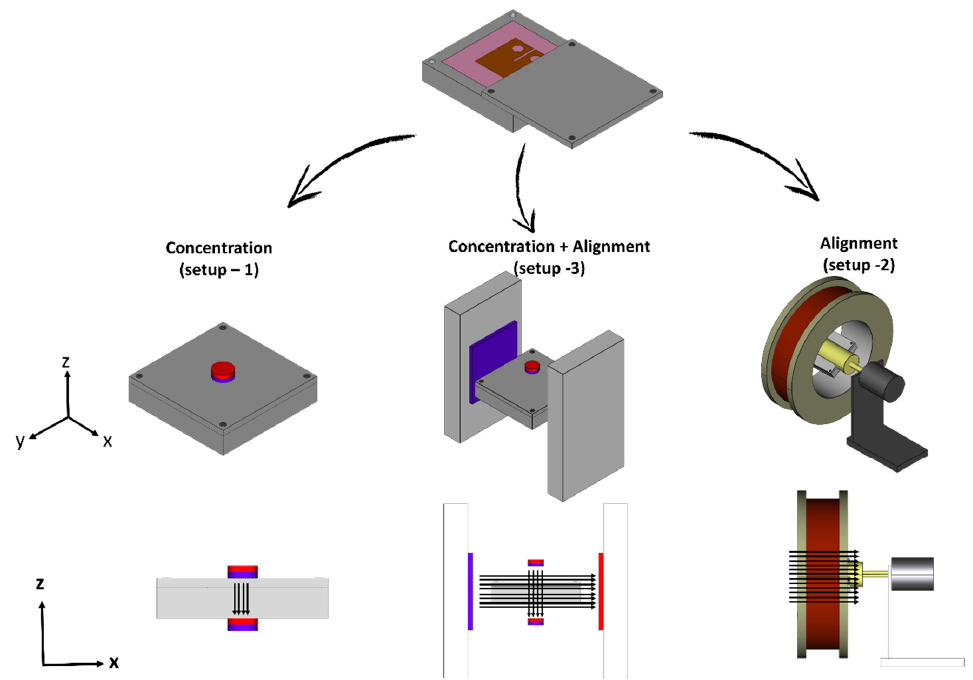
Figure 2. Curing setups of the different magnetic configurations. Top: Pre-cured resin inside a silicon mold sealed by an aluminum container is placed in one of the three setups; another set of samples is cured in the absence of magnetic field as a reference. Middle row: Three-dimensional sketches of the three setups: a pair of concentrating magnets (setup 1), a solenoid (setup 2) and a system of concentrating magnets combined with a bias field. Bottom row: the XZ -plane view of the three configurations with black arrows representing the acting field lines.